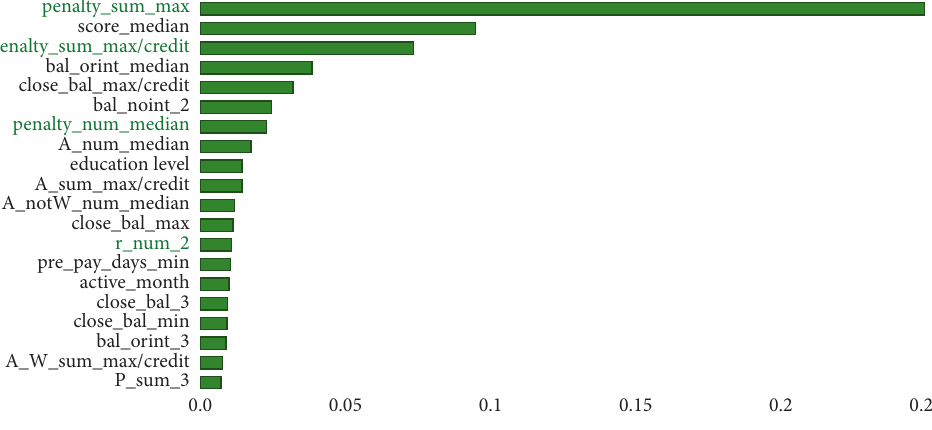
Figure 2: Feature importance index ranking of the XGBoost